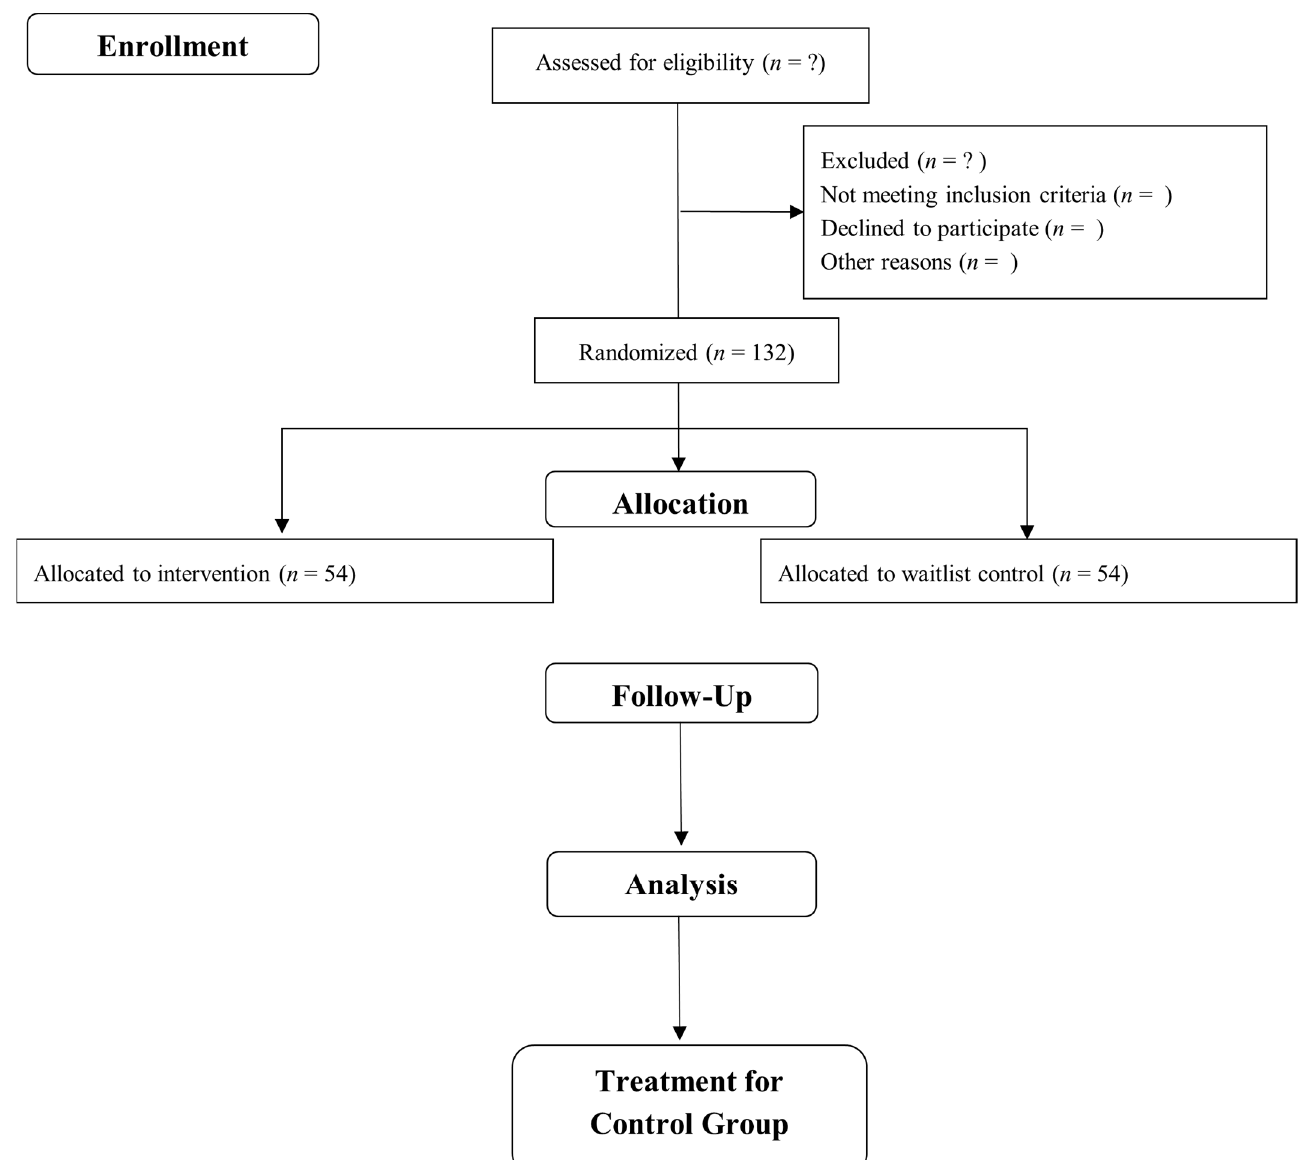
Figure 1. Consolidated Standards of Reporting Trials (CONSORT) flow diagram.